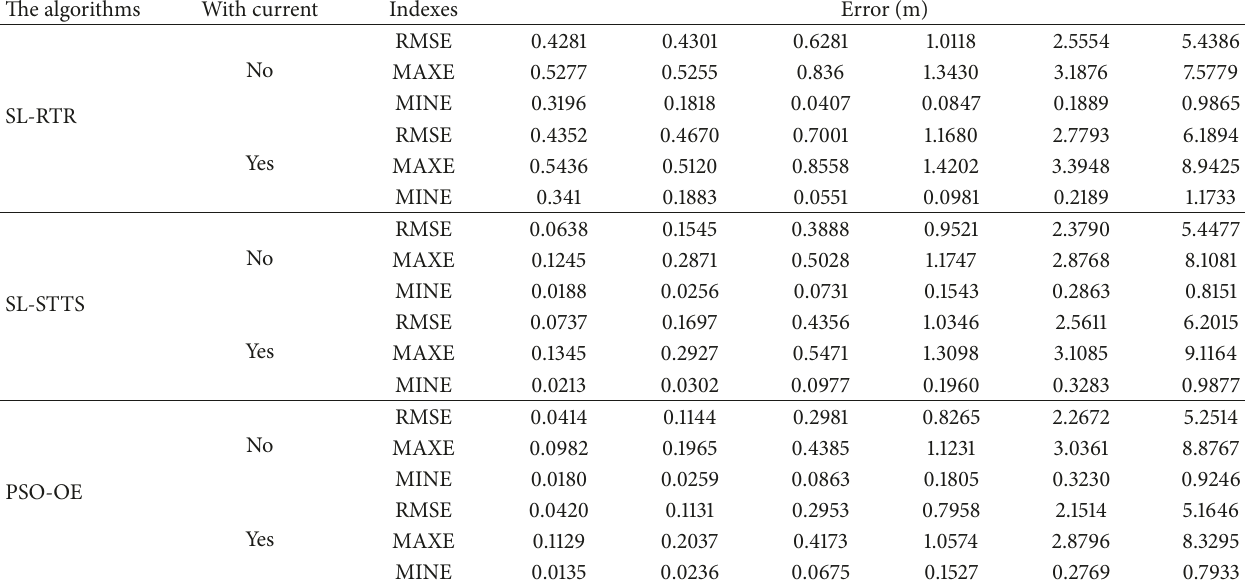
Table 3: The localization error of the localization task by different time measurement noise